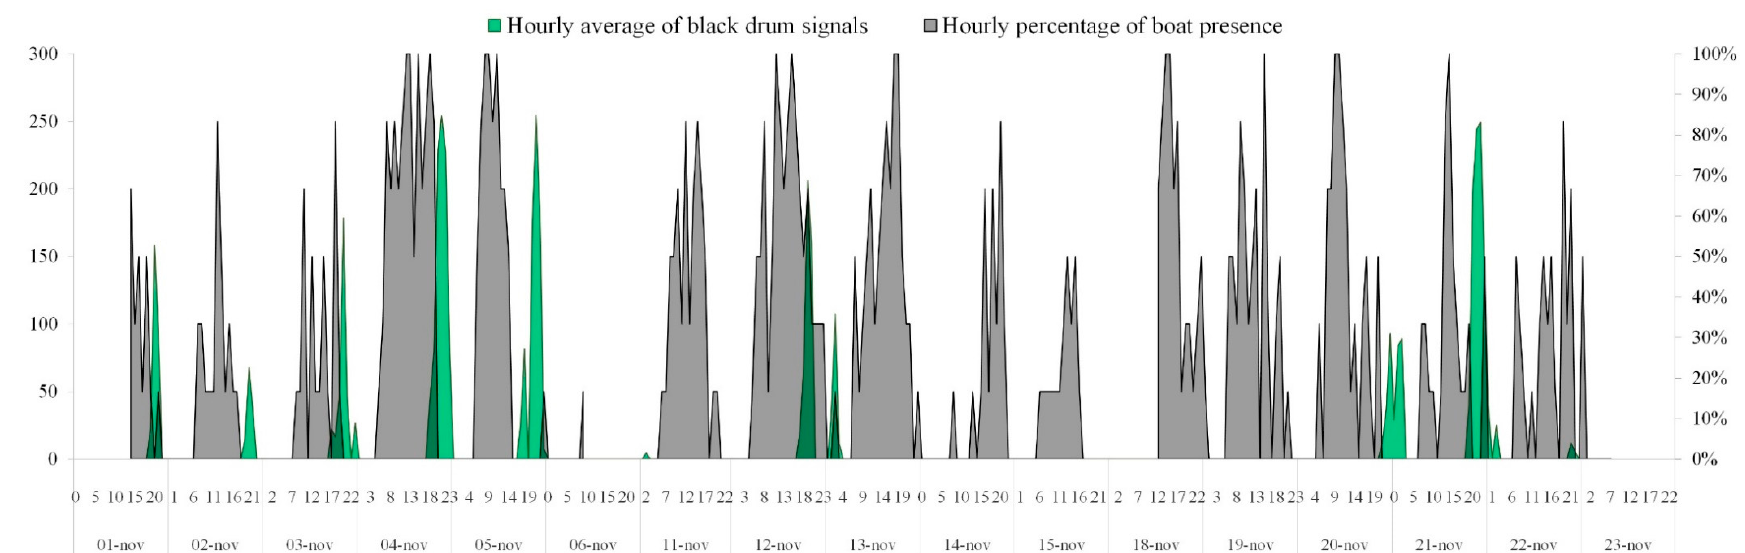
Figure 5. Hourly percentage of boat noise present (right axis, gray area) and hourly average of black drum signals (left axis, green area) for the entire sampling period. The best linear mixed model (LMM) selected included both the hour and day variables as random factors. The observed vs. predicted values, the residuals vs. predicted values, and the normal Q–Q plots are reported in Figure A1. The presence or absence of boats significantly affected the number of fish signals (ANOVA: F = 5.55, df = 3, p < 0.01, shown in Figure 6).